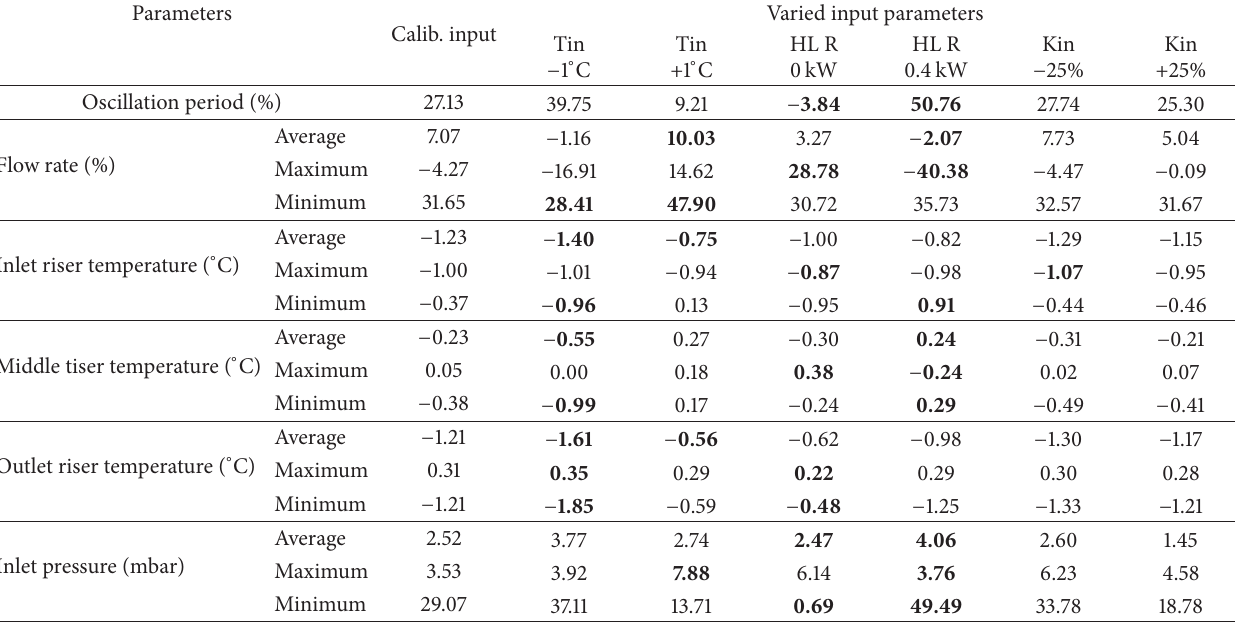
Table 5: Difference between calculated and experimental values, test I-1.